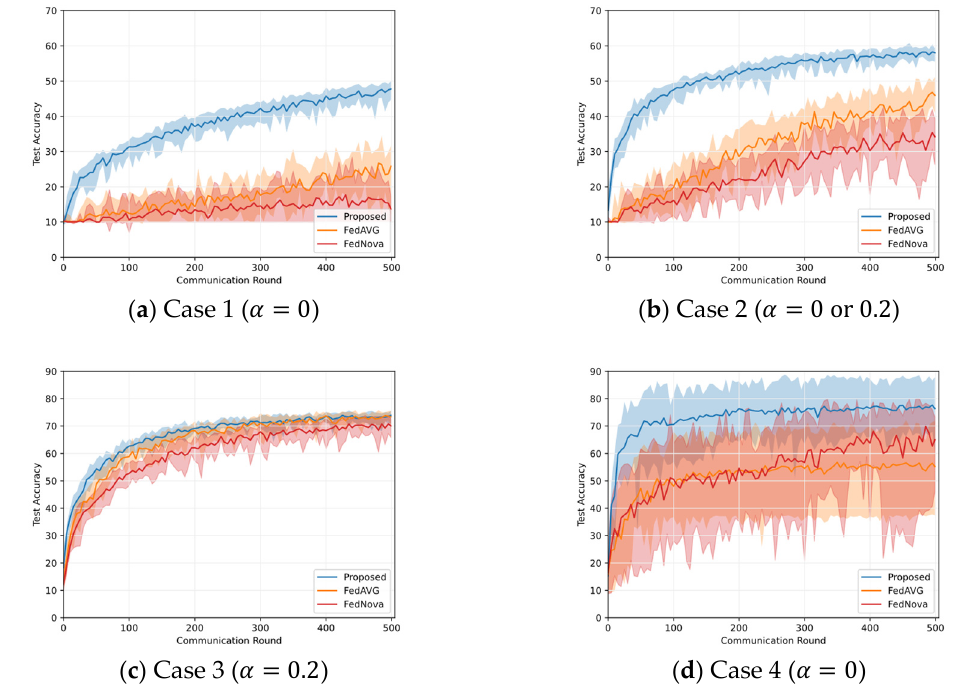
Figure 3. Accuracy comparison between the proposed algorithm and two baseline algorithms (FedAVG, FedNova) on non-IID dataset, where the bold lines represent the average of the accuracy for 10 executions and the light area is the range for the maximum and minimum values. Cases 1–3 are